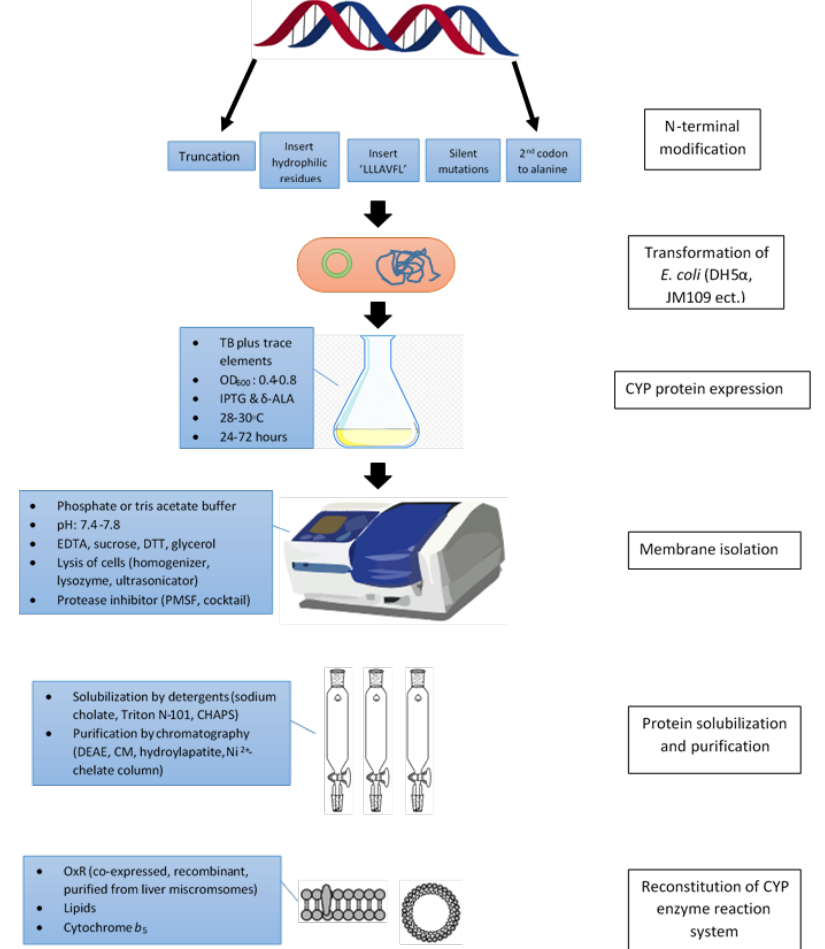
Figure 2. An overview of factors that determine successful recombinant human CYP expression from E. coli cells.